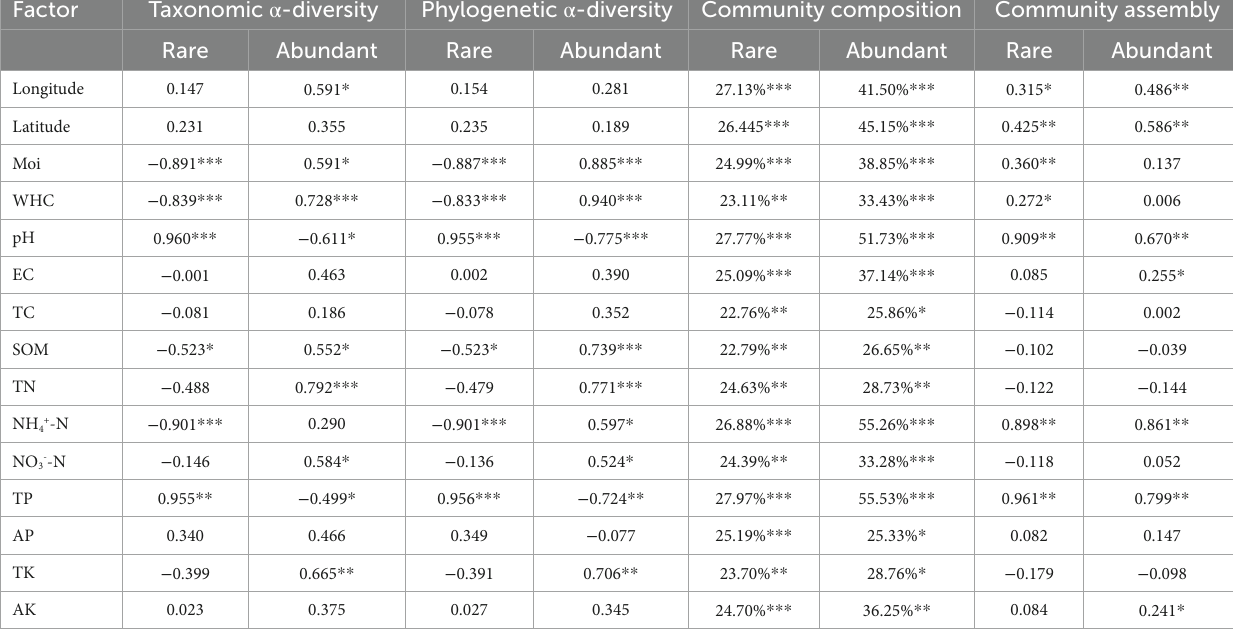
TABLE 1 Pearson’s correlations between environmental factors and α -diversities, PERMANOVA showing the pure effect of each environmental factor on community composition, and Mantel’s test of environmental variables against the β NTI of rare and abundant bacterial